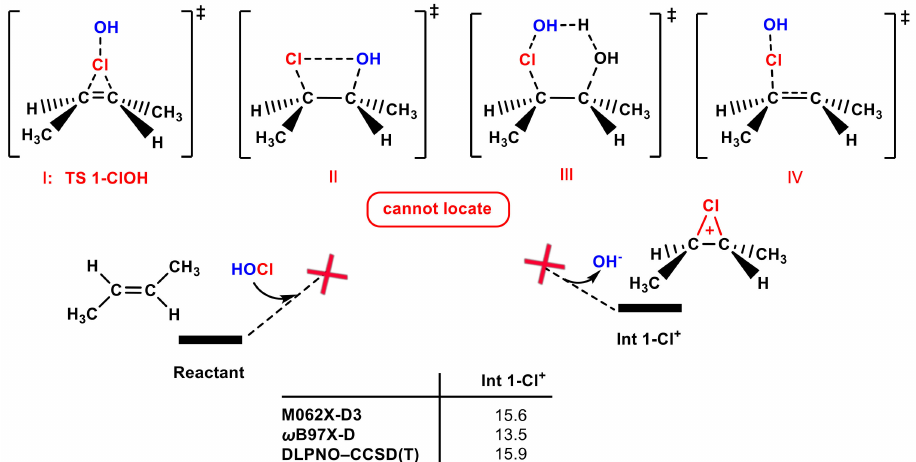
Figure 1. Four possible transition states of adding the Cl group in the HOCl molecule to trans-1,2- dimethyl ethylene, none of which can be located. Different calculation methods were used to calculate the free energies ( ∆ G ) to generate Int 1-Cl + (in kcal mol − 1 ).